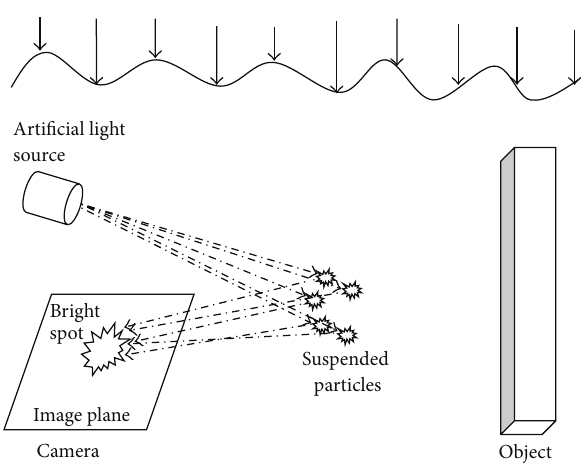
Figure 1: Nonuniform illumination created in underwater